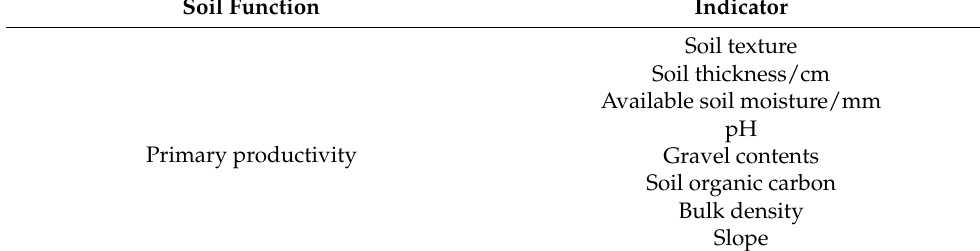
Table 1. Evaluation indicator system for cultivated land soil